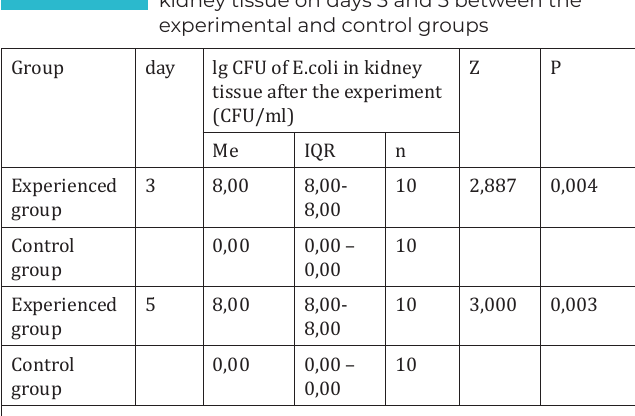
Comparative analysis of lg CFU E.coli in kidney tissue on days 3 and 5 between the experimental and control groups